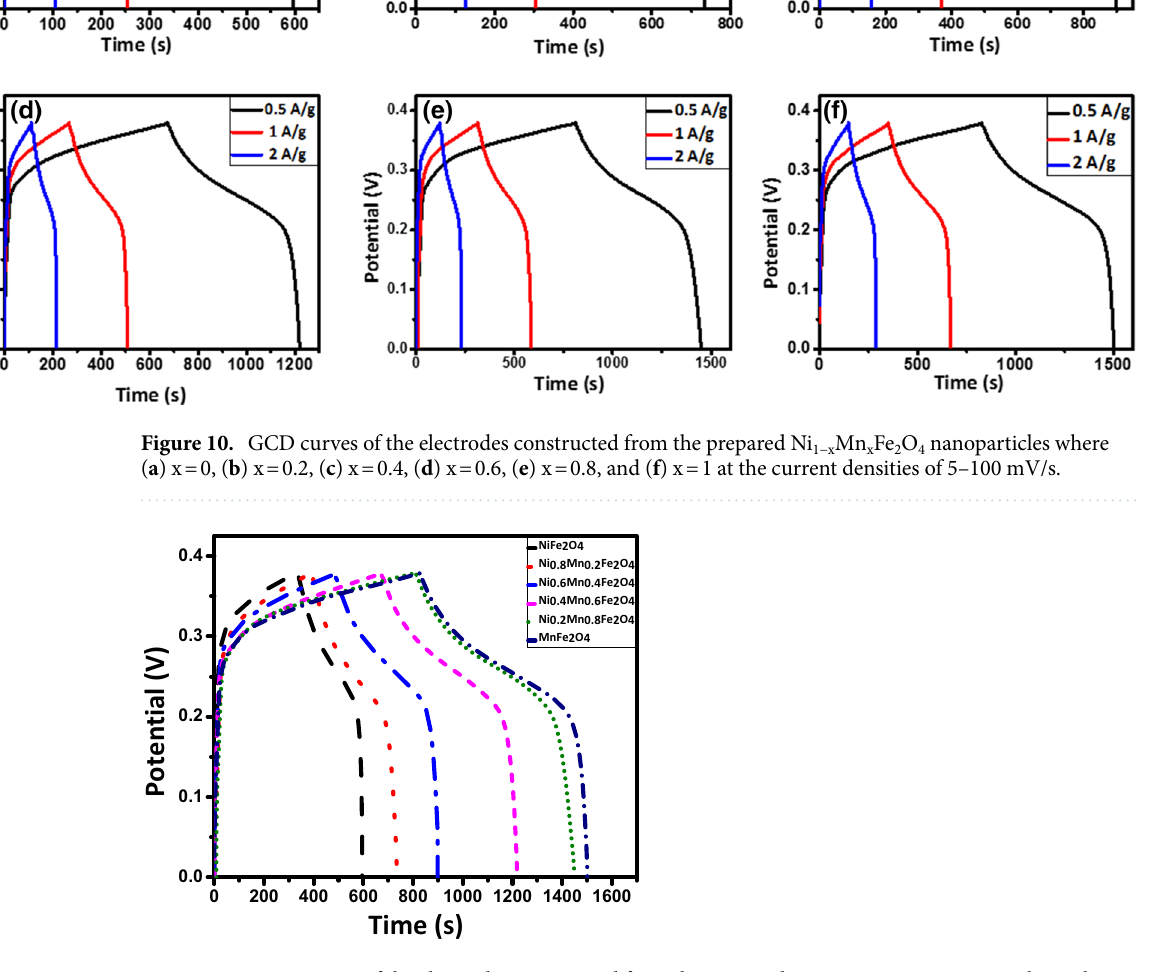
Figure 11. GCD curves of the electrodes constructed from the prepared Ni 1−x Mn x Fe 2 O 4 nanoparticles at the current density of 0.5